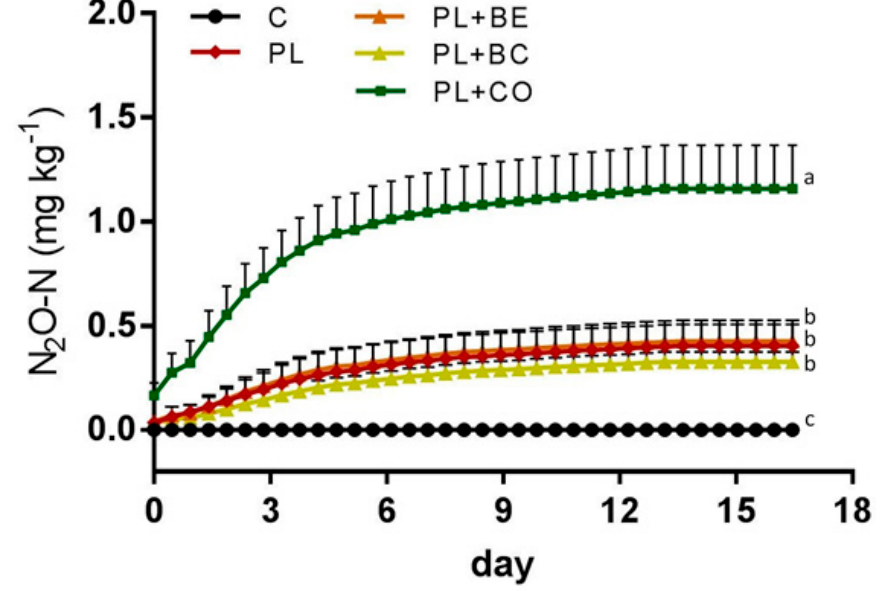
Figure 5. Mean cumulative N 2 O fluxes ( ± SD; n = 4) with in vitro laboratory incubation (N 2 O-N kg − 1 dry soil). C control (no N added), PL poultry litter, PL + BE poultry litter + bentonite, PL + BC poultry litter + biochar, PL + CO poultry litter + compost. Differences between treatments at p < 0.05 significance are marked by different letters.